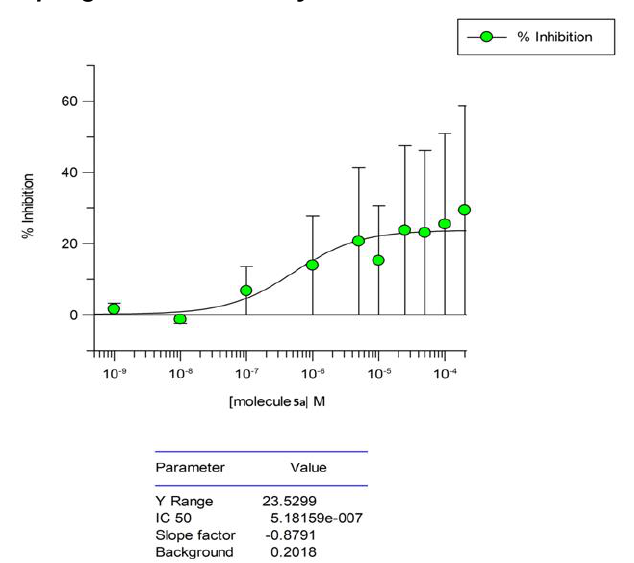
Figure 2. Alpha glucosidase inhibitory activity of compound 5a.